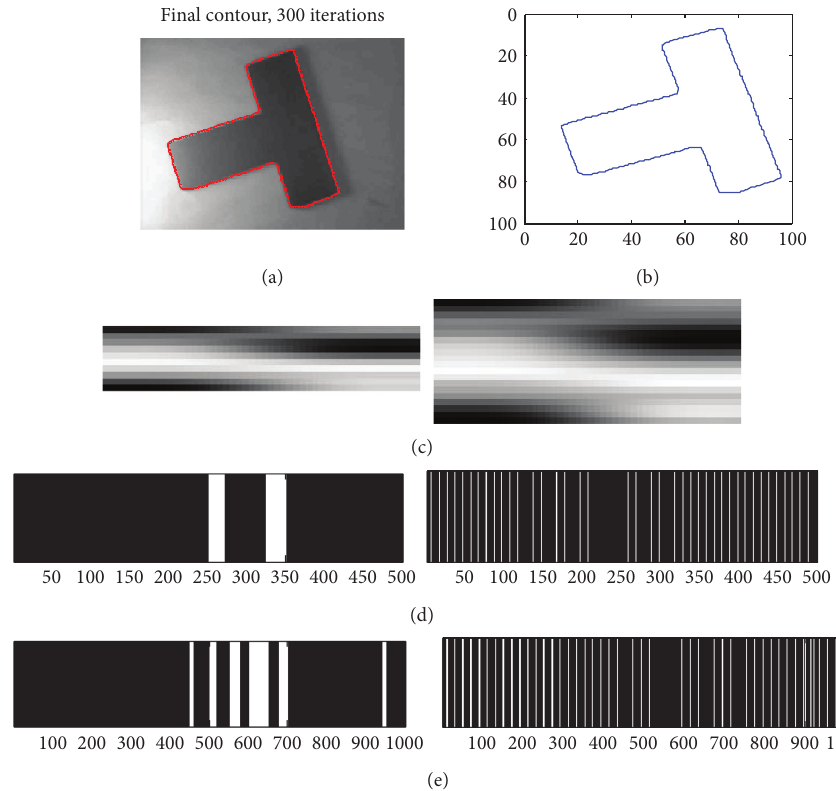
Figure 4: Image boundary feature coding results of different coding matrixes. (a) Row set LCV model image segmentation result. (b) Image contour. (c) Coding matrixes with sizes of 10 ∗ 50 and 20 ∗ 50. (d) Coding chain results of 10 ∗ 50 coding matrix in row and column directions. (e) Coding chain results of 20 ∗ 50 coding matrix in row and column